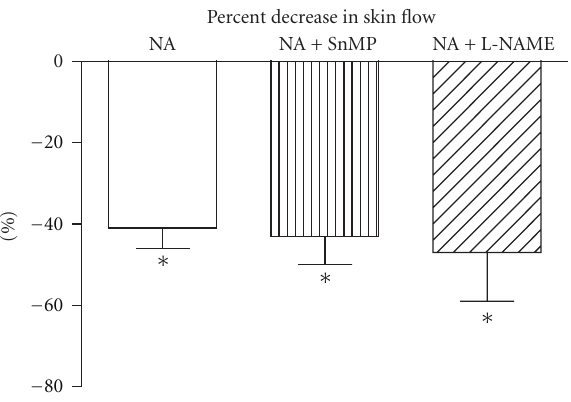
Figure 2: E ff ect of heme oxygenase inhibition with stannous meso- porphyrin IX (SnMP) (200 µ M) and nitric oxide synthase inhibition with L-NG-Nitroarginine methyl ester (L-NAME) (100 µ M) on the vasoconstricting e ff ect of noradrenaline (NA) on skin blood flow measured by laser Doppler flowmetry. NA, SnMP, and L- NAME were locally administered by iontophoresis. ∗ P < 0 . 05 versus